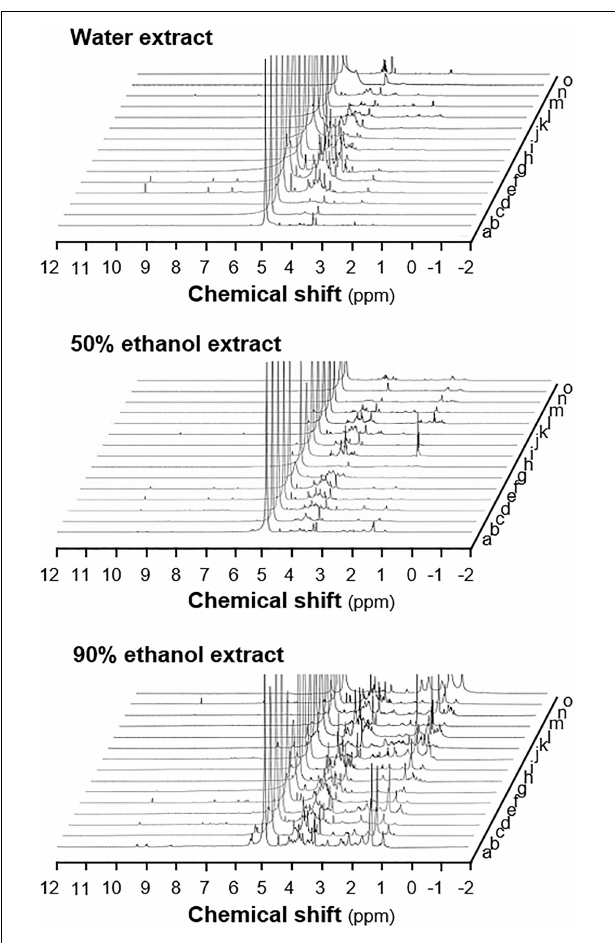
FIGURE 3 | 1 H NMR profiles of herbal extracts from the 15 spleen-meridian herbs. The extracts (50 mg) were dissolved in 400 µ L of D 2 O and centrifuged at 13,000 × g for 1 min before transferred to a standard 5-mm NMR tube. The 1 H NMR experiment were conducted on a Varian 300 MHz NMR spectrometer, operating at 300.13 MHz 1 H NMR frequency at 298 K. The spectra were acquired using a 1D CPMG pulse sequence (RD-90 ◦ -t1-90 ◦ -tm- 90 ◦ -acquire) to generate a spectrum with a reduced residual solvent peak. The range of chemical shift was set from –2 to 12 ppm, and the deuterated solvent peak at 4.8 was set as calibration. The extracting solvents are indicated. The extracts from 3 batches of herbs were subjected to analysis, a representative profile was shown. a, Codonopsis Radix; b, Atractylodis Macrocephalae Rhizoma; c, Angelicae Sinensis Radix; d, Astragali Radix; e, Jujubae Fructus; f, Ginseng Radix; g, Amomi Fructus; h, Aucklandiae Radix; i, Areca Catechu; j, Dioscoreae Ahizoma; k, Lablab Semen Album; l, Poria Cocos; m, Nelumbinis Semen; n, Coicis Semen; o, Crataegi Fructus.